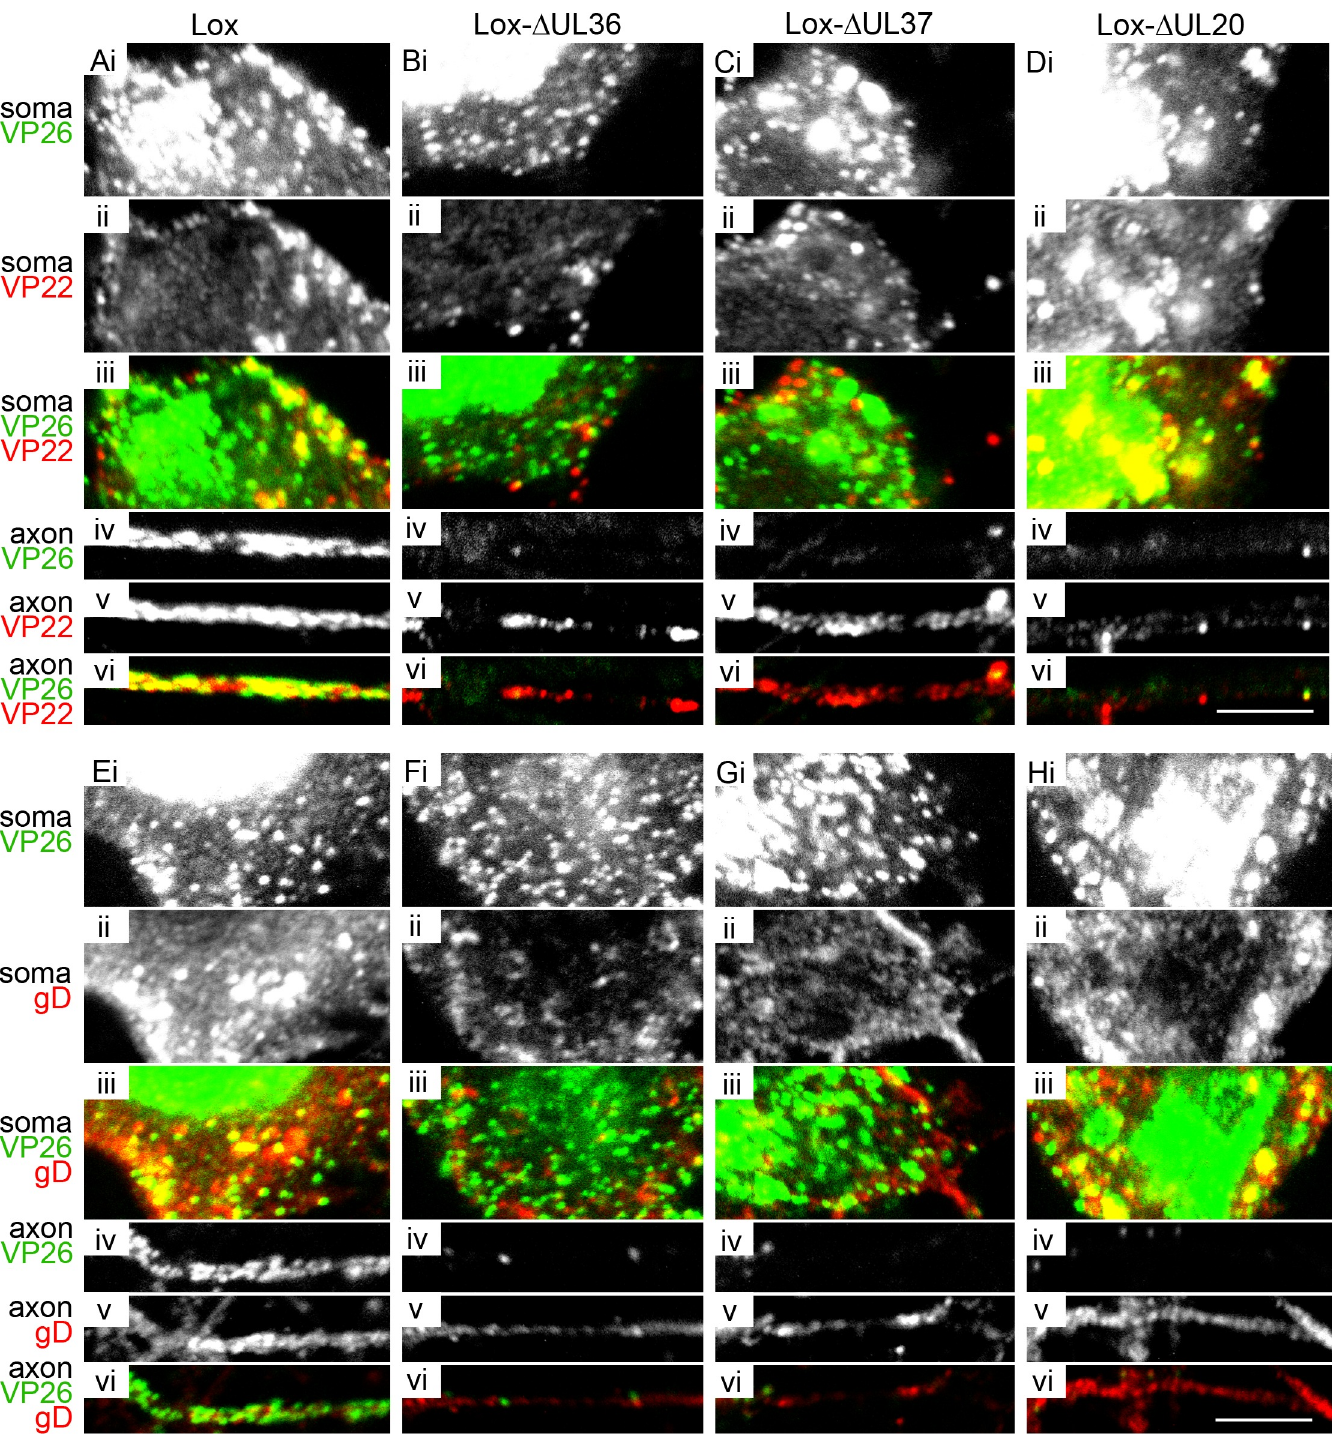
Fig 6. HSV1-pUL36, pUL37 and pUL20 are required for efficient targeting of capsids to axons. DRG neuronswere infected after 3 div with 1 x 10 7 pfu/ mL of HSV1(17 + )Lox (A and E), - Δ UL36(B and F), - Δ UL37(C and G), or - Δ UL20(D and H), fixed and permeabilizedusing the PHEMO protocolat 26 hpi, labeled with antibodies directed againstVP26 (pAb VP26 aa95-112 ) and VP22 (mAb 22–3, A-D) or gD (mAb DL6, E-H), and analyzedby confocalfluorescence microscopy. (i and iv) anti-VP26, (ii and v) anti-VP22in the upper panel and anti-gDin the lower panel, (iii and vi) anti-VP26 in green and anti-VP22in the upper paneland anti-gD in the lower panel in red. (i-iii) Cell bodieswith nucleus and cytoplasm; (iv-vi) proximalaxons. Scale bar, 5 μ m.